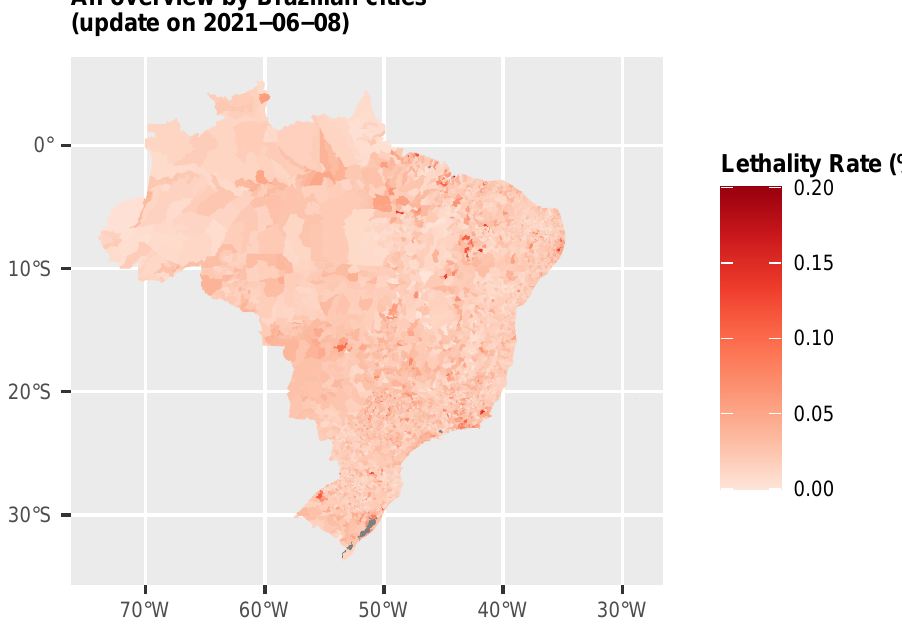
Figure 3. Map of an overview of the lethality (%) rate in Brazil by cities (S are degrees South and W are degrees